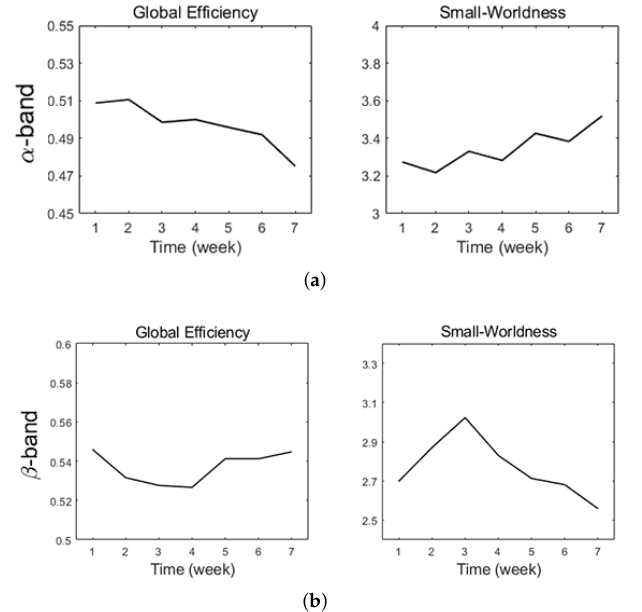
Figure 5. Complex network measures. ( a ) α -band network ( b ) β -band network For the α -band network, we observed a decreasing trend of global efficiency over the training period, suggesting that the efficiency of the α -band network decreased over